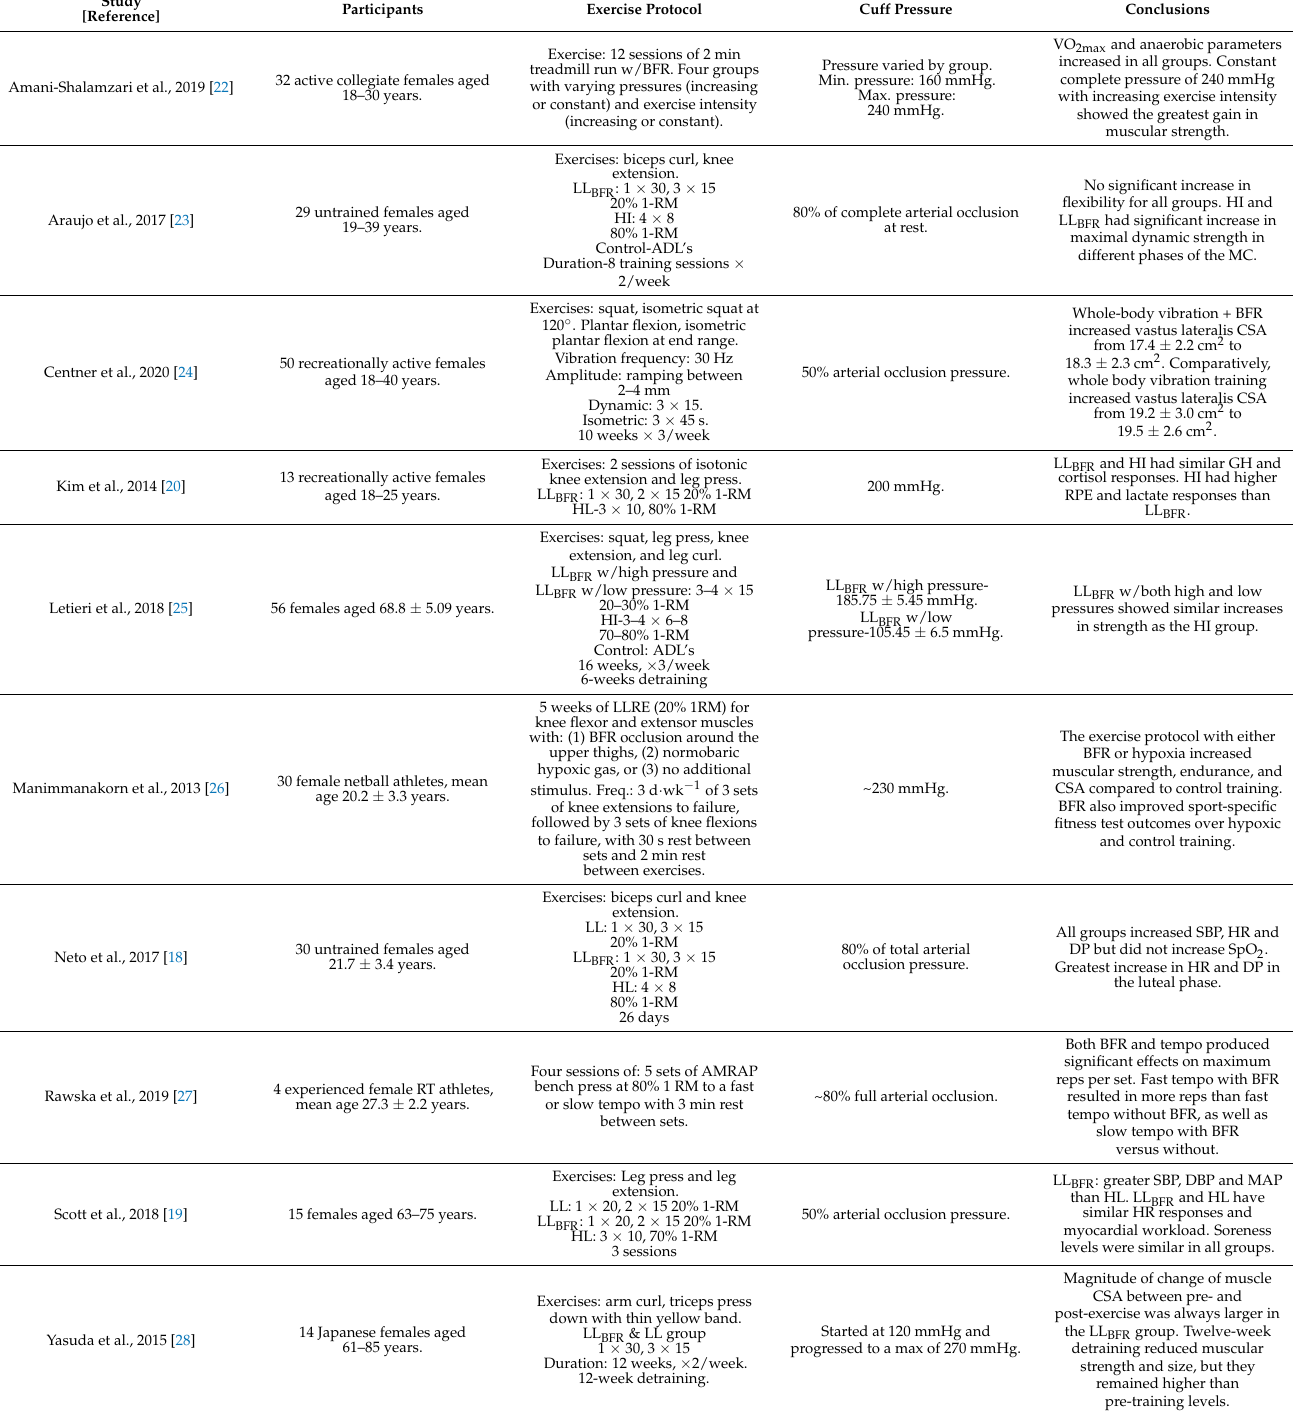
Table 2. Summary of blood flow restriction studies among female athletes